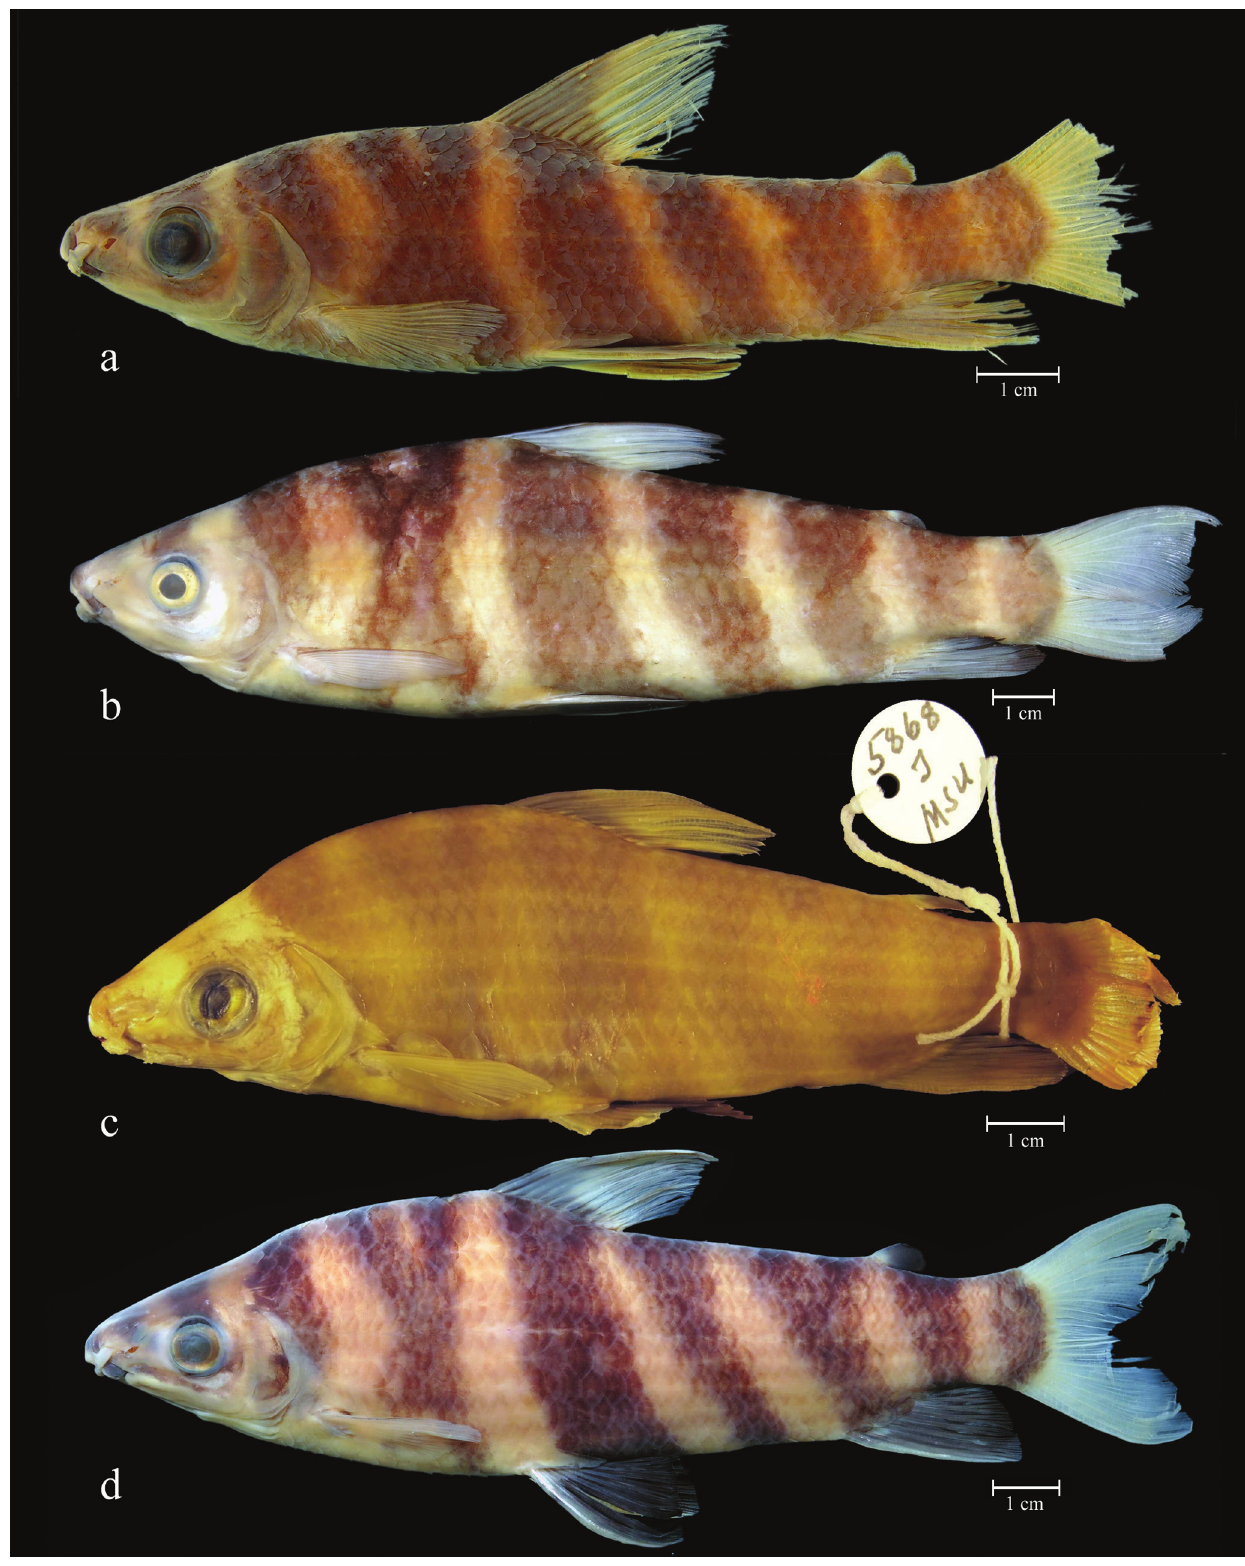
Fig. 11. (a) Leporinus desmotes , holotype, ANSP 39324, 146.4 mm SL, Rupununi river, Guyana, (b) Leporinus desmotes , MZUSP 105585, 152.0 mm SL, rio Itacaiúnas, Tocantins basin in Brazil, (c) Leporinus jatuncochi , holotype, MSUM 5868, 122.0 mm SL, Laguna Jatuncochi, Orellana in Ecuador, (d) Leporinus jatuncochi , MUSM 34192, 149.3 mm SL, Peru. All specimens